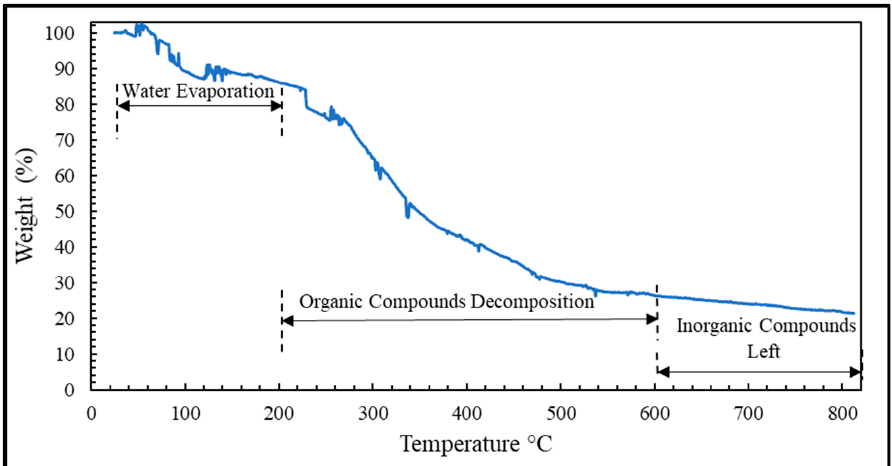
Figure 10. TGA of UF membrane foulants.